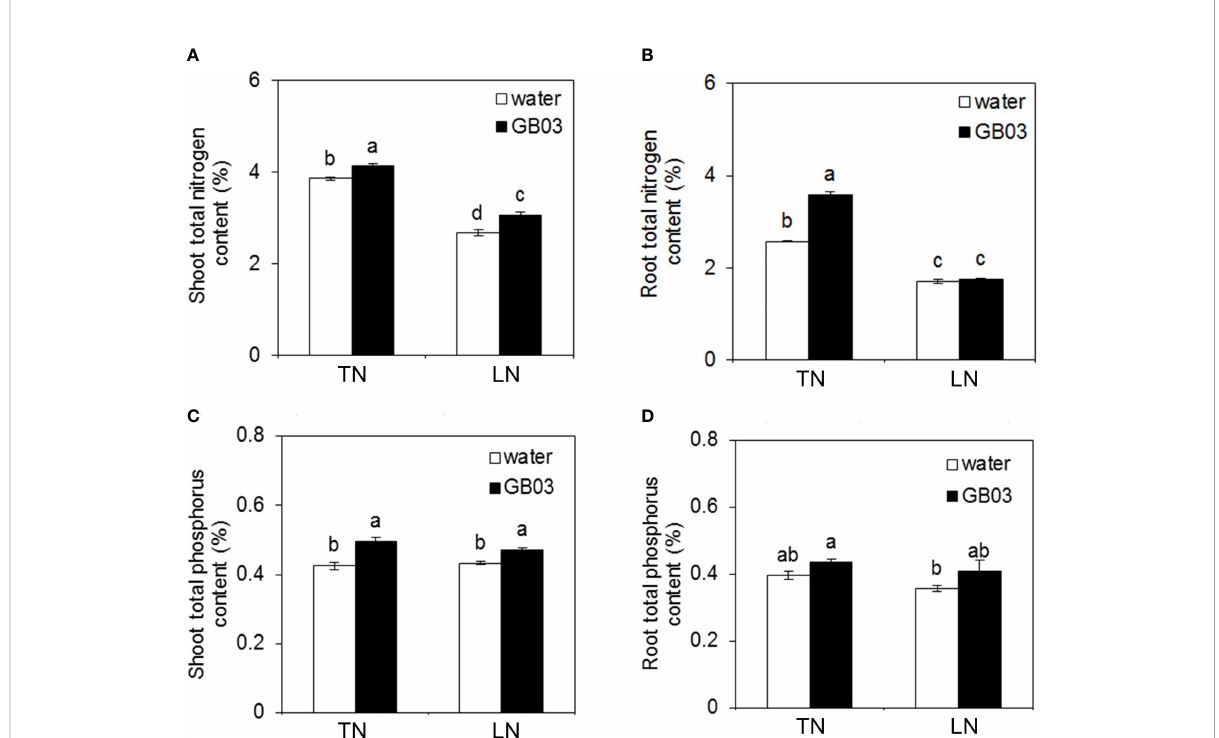
FIGURE 3 Effects of GB03 on N and P in tall fescue under various concentrations of NO 3- . (A) Shoot total nitrogen content, (B) root total nitrogen content, (C) shoot total phosphorus content, and (D) root total phosphorus content. Values are means ± SE ( n = 8), and bars indicate SE. Columns with different letters indicate signi fi cant differences at p < 0.05 (Duncan ’ s test).